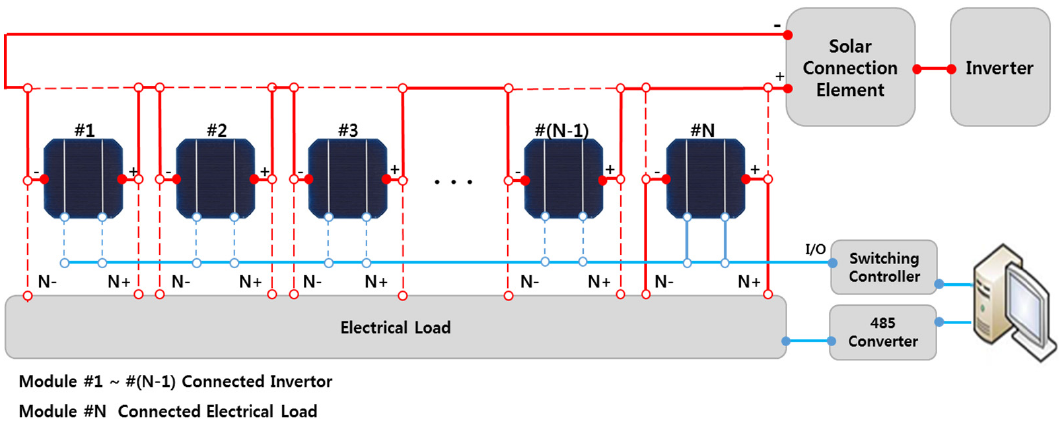
Figure 3. Monitoring and measurement setup for the modules in the mock-up.